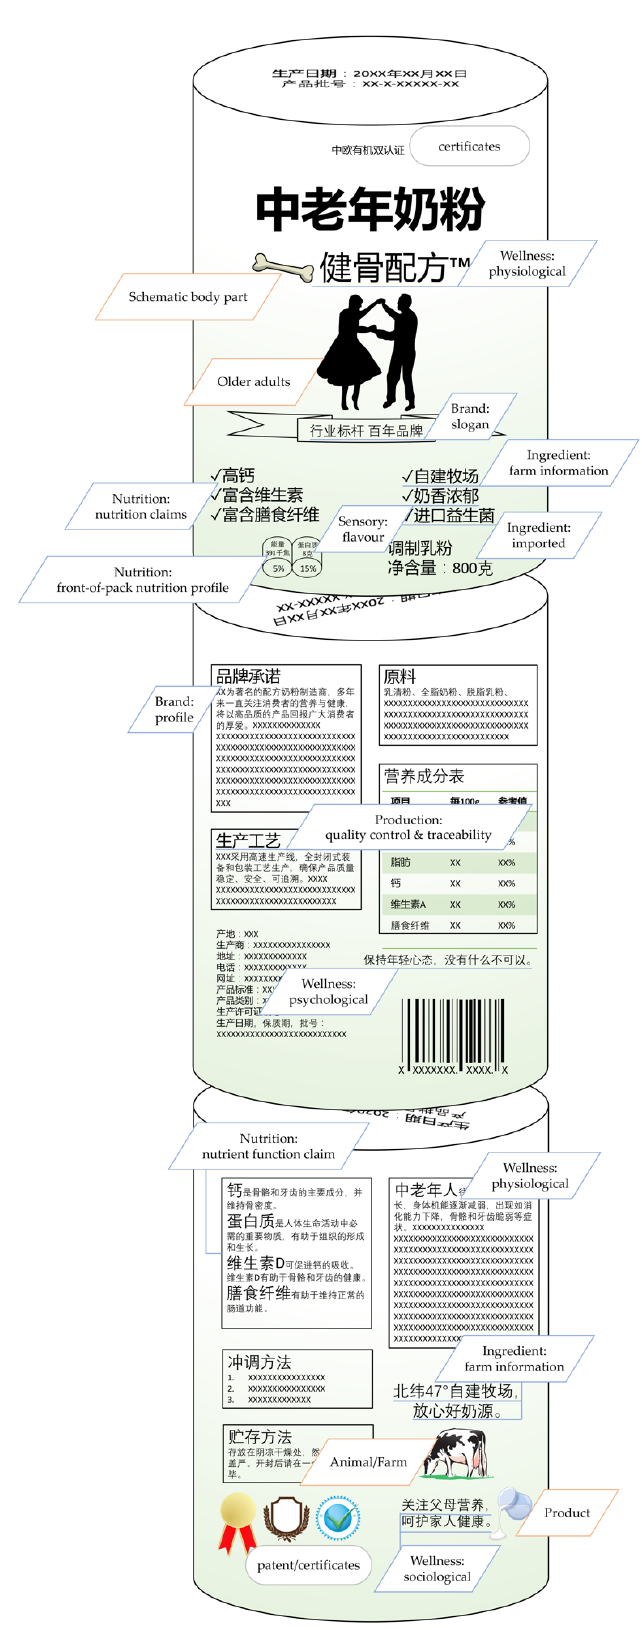
Figure 2. On-the-pack voluntary well-being messaging: textual ( ), graphical ( ) from manufacturers and certificates and patent from the third parties ( ) as extracted from an example milk targeting Chinese older adults.